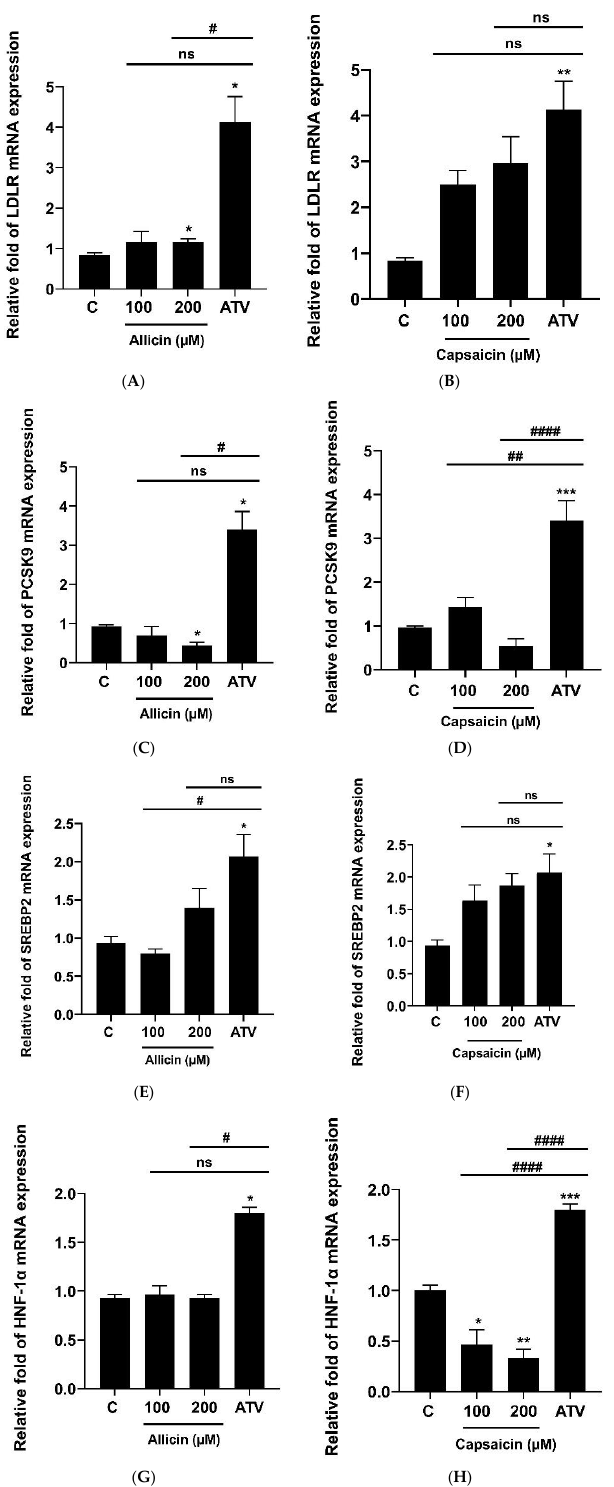
Figure 2. Effects of allicin (100, 200 µ M) and capsaicin (100, 200 µ M) on LDLR ( A , B ), PCSK9 ( C , D ), SREBP2 ( E , F ), and HNF1 α ( G , H ) mRNA expression in HepG2 cells. ( A ) HepG2 cells were treated with allicin (100, 200 µ M), capsaicin (100, 200 µ M), or atorvastatin (10 µ M) for 24 h. The mRNA expression of LDLR was determined by RT-qPCR. The data represent the mean ± SEM of three independent experiments ( N = 3). * p < 0.05, ** p < 0.01, and *** p < 0.005 represent significant differences compared to the vehicle-treated cells or the control group (C). # p <0.05, ## p < 0.01, and #### p < 0.001 represent significant differences compared to atorvastatin (ATV)-treated cells. ns: not